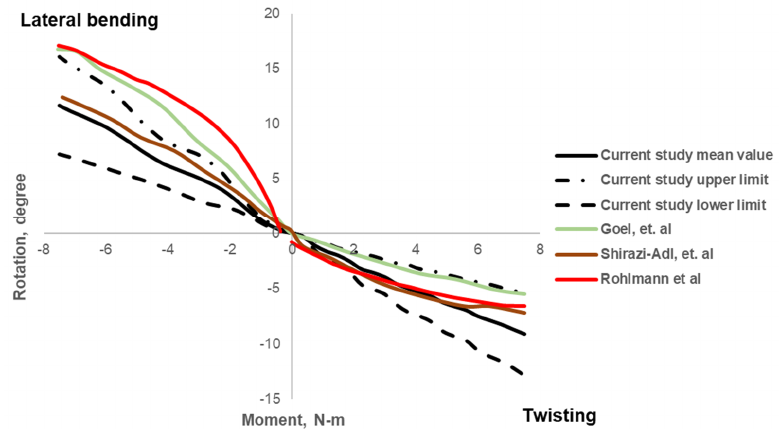
Figure 6. Variation of angle with respect to applied moment on the superior surface of the lumbar model during lateral bending and twisting movement. We observed a strong correlation (R 2 : 0.8, p < 0.01) between FE-predicted FL and BMD QCT-L1-L3 values in all subjects. The correlation plot is shown in Figure 7.